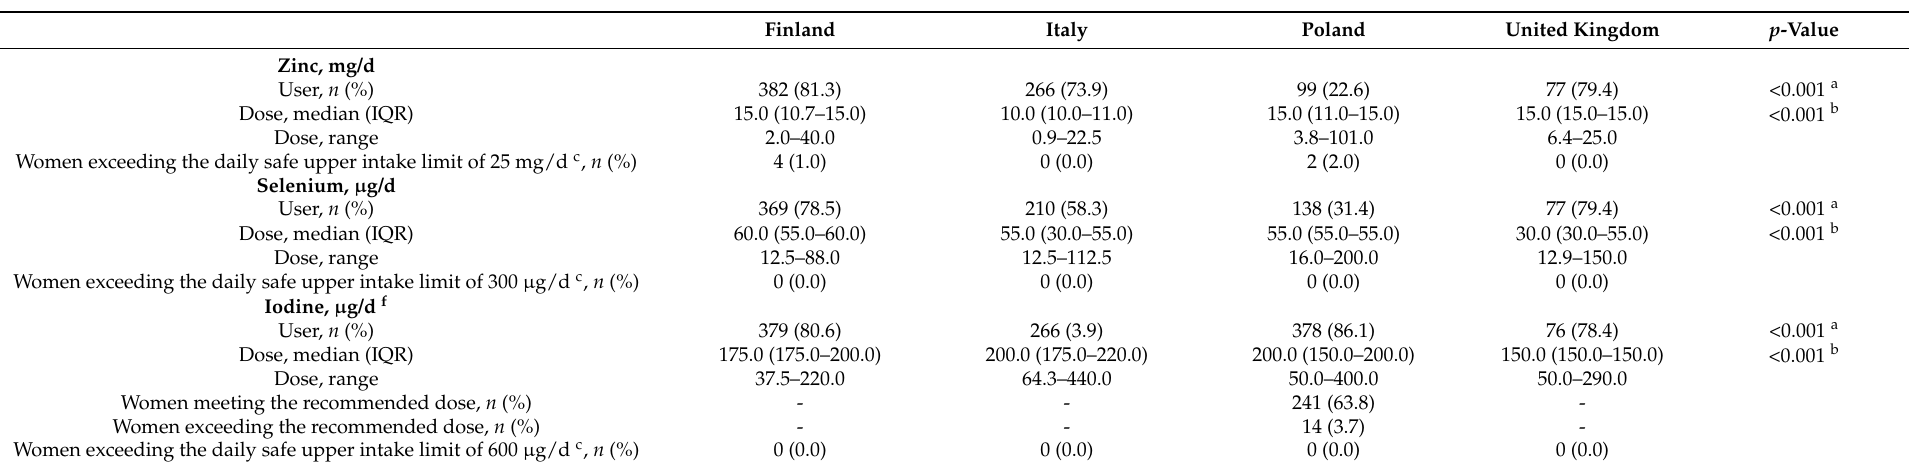
a Comparison between the countries, Chi-square test with Bonferroni correction. b Comparison between the countries, Kruskal–Wallis test with Bonferroni correction. c Safe upper intake limit reported as set by the European Food Safety Authority [22]. d Recommended intake of folic acid from supplements during pregnancy: 400 µ g/d in each country in the low-risk group. e Recommended intake of vitamin D from supplements during pregnancy: 10 µ g/d in Finland and the UK, 50 µ g/d in Poland, no recommendation in Italy. f Recommended intake of iodine from supplements during pregnancy: 200 µ g/d in Poland, no recommendation in other